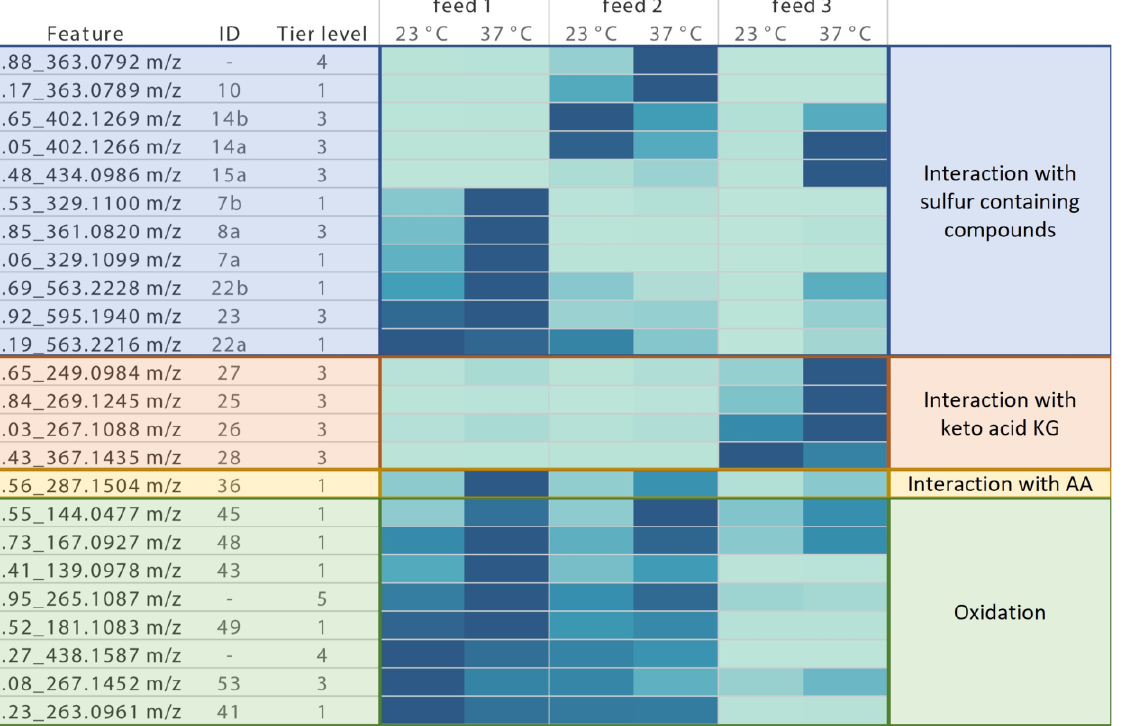
Figure 3. Impact of each additive on thiamin degradation product formation in liquid feeds when stored for 91 days or 98 days at 23 °C and 37 °C light protected. Only features with an abundance of minimum 10,000 at both temperatures were selected. AUC was normalized on highest value for each degradation product. Light blue color indicates that the feature was not detected or only background signal was detected. Change from light to dark blue indicates an increase in feature signal. Blue highlighted features indicate interaction products between thiamin- and sulfur-containing compounds. Orange highlighted features indicate interaction products between thiamin and KG. Yellow highlighted features indicate interaction products between thiamin and AAs. Green highlighted features indicate thiamin oxidation products.